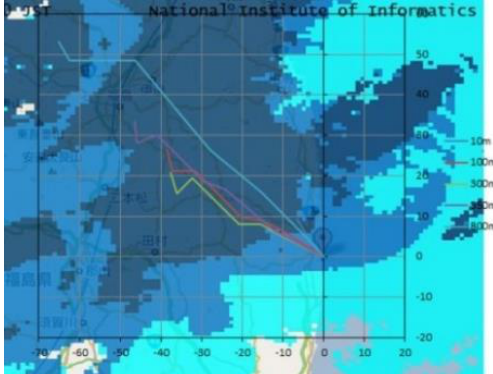
Figure 7. Flying particles and rain clouds at 0:00